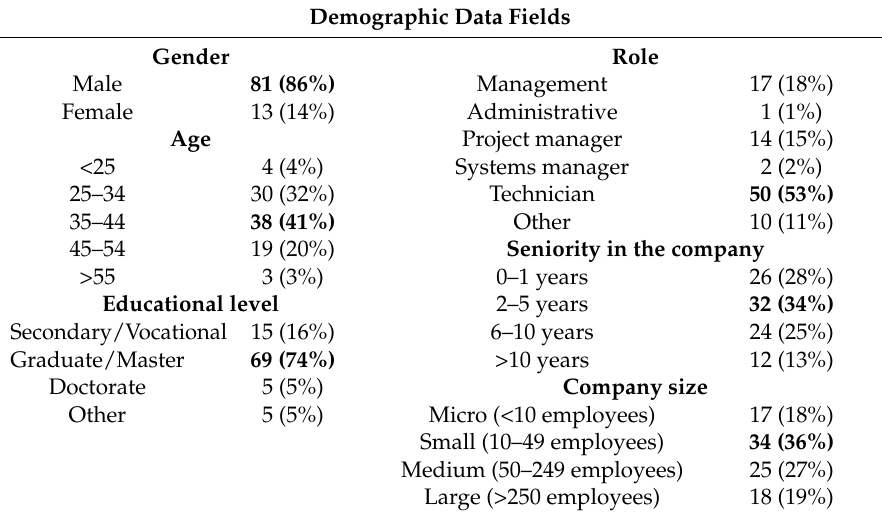
Table 3. Demographic